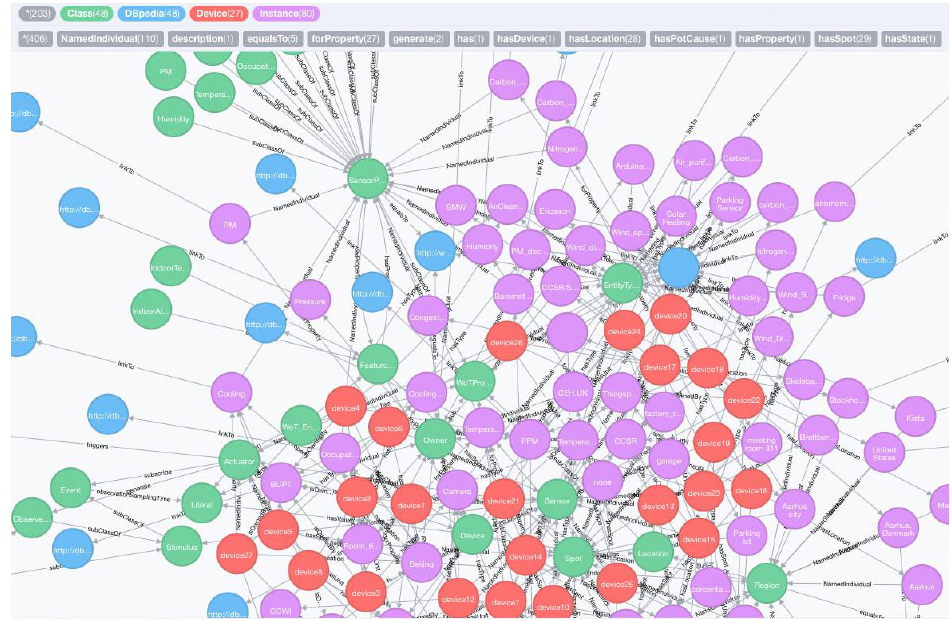
Figure 13. Parts of the EL results stored in Neo4i graph database. The blue circles represent the linked entities and types to DBpedia. It is annotated as the “linkTo” property.